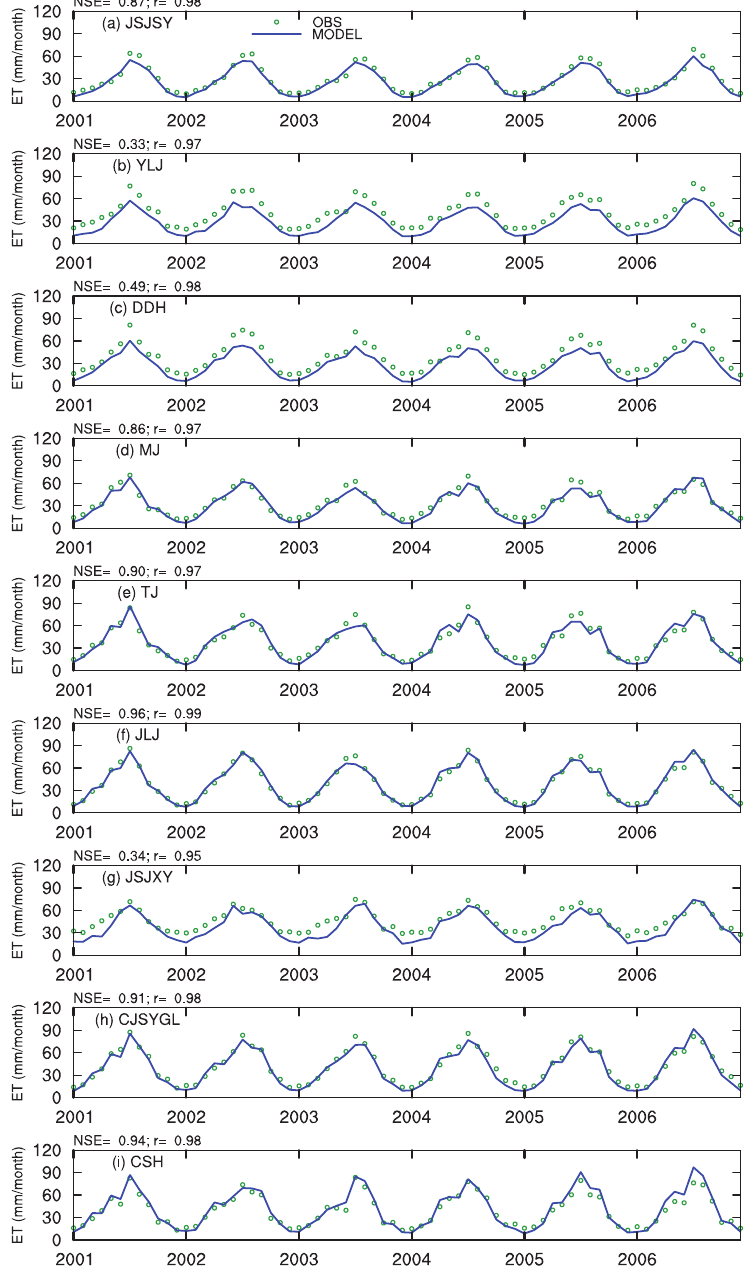
Figure 4. Comparison between modeled and remote sensing-retrieved (ET_Zhang) spatial average evapotranspiration (ET) in ten sub-regions ( a – i ) from 2001 to